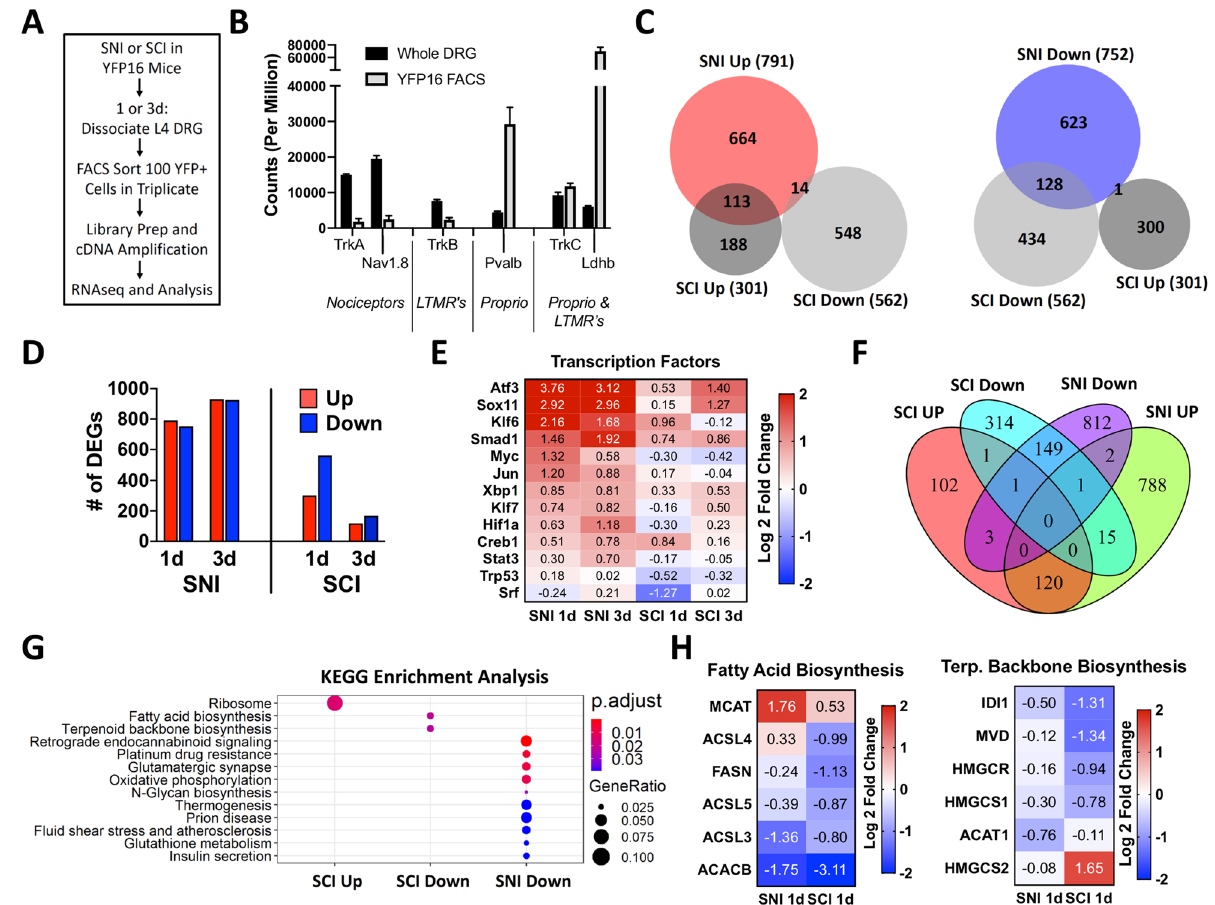
Figure 3. Spinal Cord Injury (SCI) induces an acute transcriptional response in ascending DRG sensory neurons that mostly differs from sciatic nerve injury (SNI). ( A ) Schematic of the experimental design for fluorescence-activated cell sorting (FACS) of ascending DRG sensory neurons from Thy1YFP16 mice 1 or 3 days after SNI or SCI (n = 3 mice per group, except n = 4 mice for naïve and SCI 1d). ( B ) Total counts of genes associated with three predominant neuronal subtypes in the DRG (nociceptors, low-threshold mechanoreceptors (LTMR), and proprioceptors (Proprio) ( C ) Proportional venn diagrams for differentially expressed (DE) genes upregulated (red) or downregulated (blue) 1 day after SNI and SCI in ascending DRG sensory neurons, and ( D ) Number of DE genes 1 and 3 days after SNI or SCI ( p -adj < 0.1, r = 2 for RUVr). ( E ) Heatmap of known regeneration-associated transcription factors (RATFs) 1 and 3 days after SNI and SCI in ascending DRG sensory neurons. ( F ) Venn diagram and ( G ) KEGG pathway analysis of DE genes 17–19 , 1 and 3 days after SNI or SCI that have ATF3 binding sites. SNI upregulated DE genes did not lead to significant pathway enrichment. ( H ) Heatmap of genes that ATF3 binding sites associated with fatty acid biosynthesis and terpenoid backbone biosynthesis 1 day after SNI and SCI in ascending DRG sensory neurons. Only HMGCS2 does not have an ATF3 binding